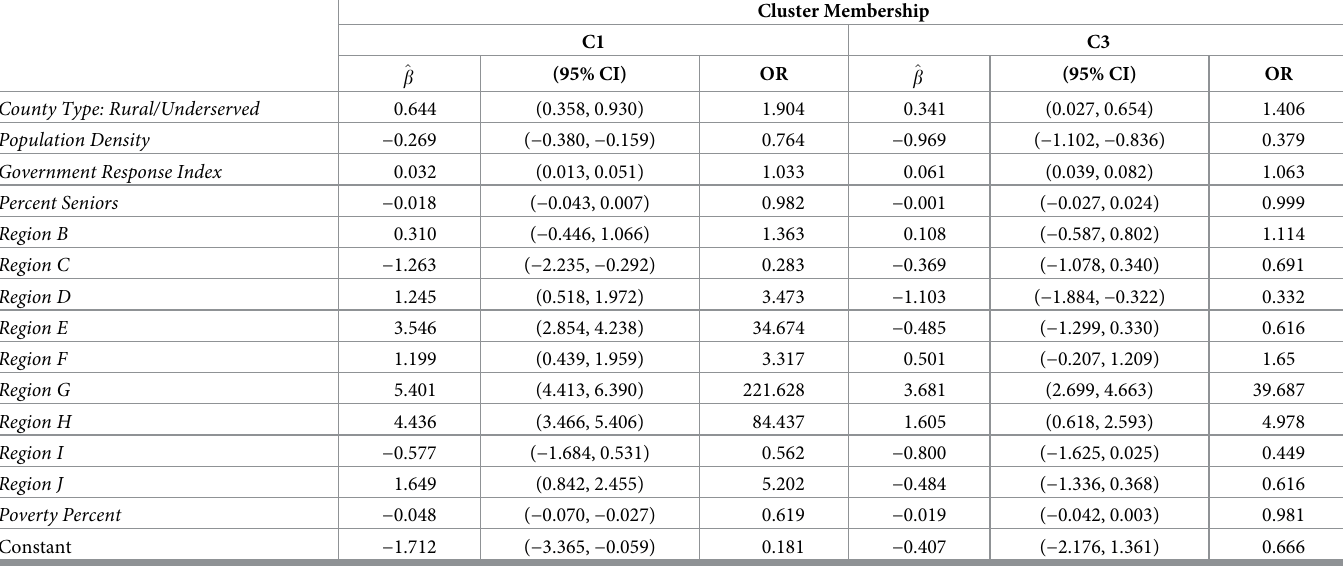
indicated by the column vs. the baseline cluster. Similarly, the OR shows the multiplicative change in the odds of a county classifying in the corresponding cluster as indicated by the col- umn vs. the baseline cluster. For example, in the columns of Table 2, labeled C1, the first coeffi- cient corresponds to the variable County Type Rural/Underserved . The coefficient, 0.644, Table 2. Results of multinomial logistic regression for the probability of falling in C1, and C3. Note that we have used C2 as the reference cluster since it contained the largest number of